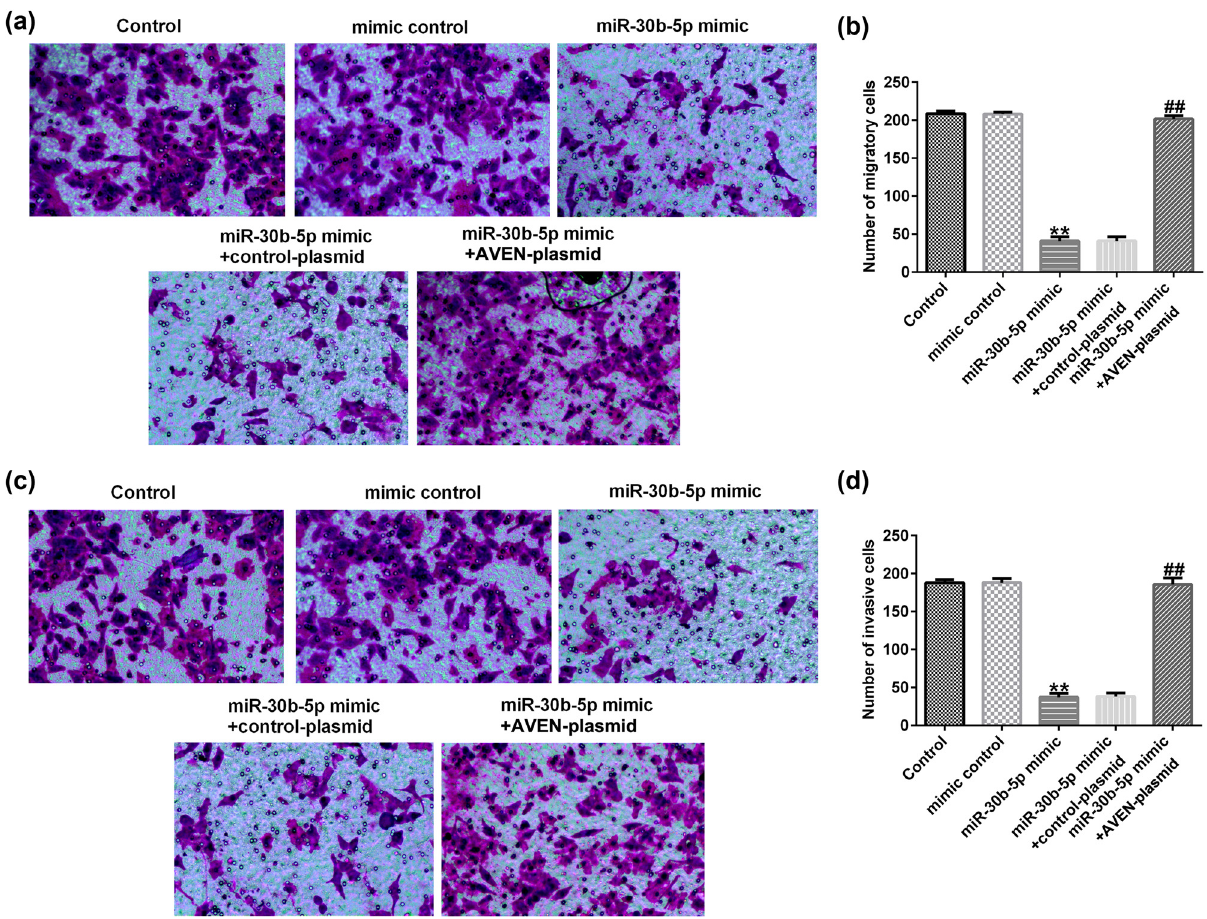
Figure A1: miR - 30b - 5p overexpression inhibits migration and invasion in SW480/R via AVEN. ( a – d ) Transwell assay was carried to carried to measure SW480/R cells migration and invasion. Data were represented as the mean ± SD of three independent experiments. ** P < 0.01 vs Mimic control; ## P < 0.01 vs miR - 30b - 5p mimic + control -